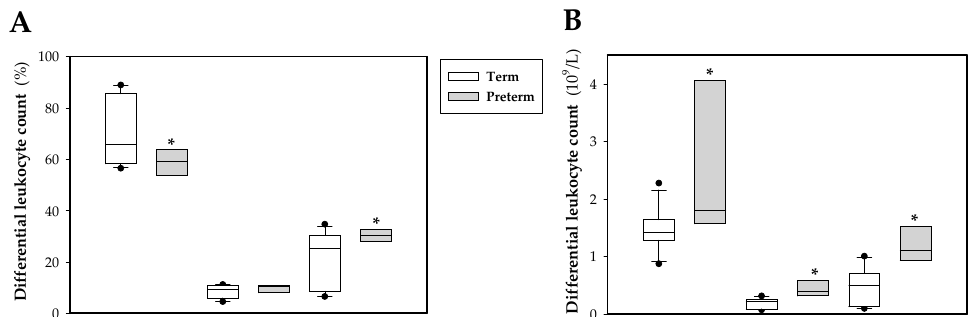
Figure 2. Box plot of differential leukocyte count in percentage ( A ) and in absolute values ( B ) at the end of the study (day 10) in both experimental groups. Line indicates the median, box shows the interquartile range (IQR) and the whiskers are 1.5 × IQR ( n = 10 pups per group). Statistical differences: * p < 0.05 vs. term group.